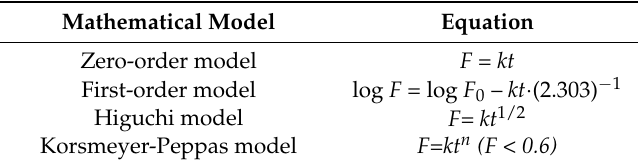
Table 1. Mathematical models of kinetic or release